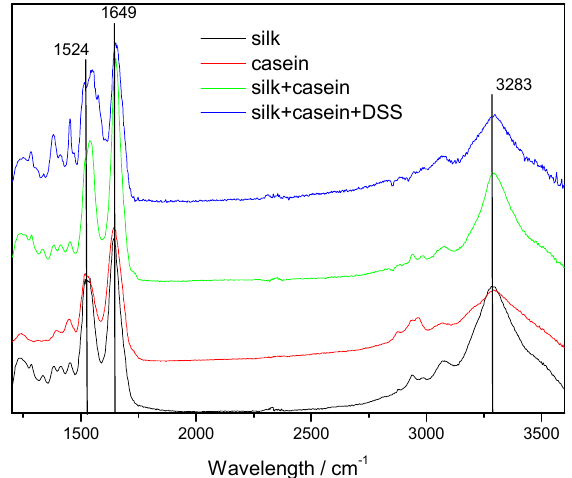
Figure 3. ATR-FTIR spectrum of electrospun nanofibers: silk (SFs, black line), casein (cast film, red line), CSFs (green line), and CSFs/15% DSS (blue line).